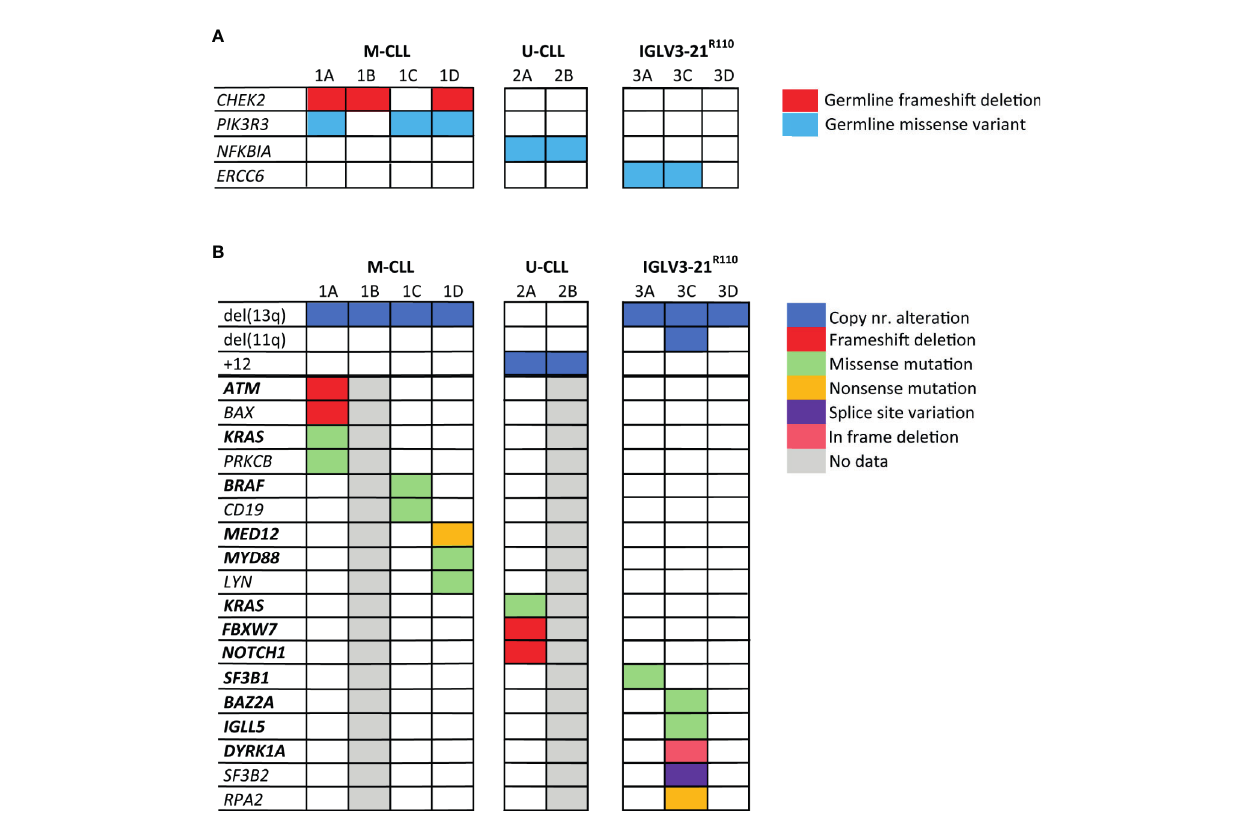
FIGURE 2 | Somatic mutations and germline variants detected by whole genome sequencing of the CLL families. In this fi gure, both germline variants (A) and somatic genetic alterations (B) detected in the CLL families are shown. The genes highlighted in bold text are genes, which have previously been identi fi ed as CLL driver genes. Genes that are not in bold text were identi fi ed during KEGG pathway analysis. Only mutations/variants with likely functional consequences related to CLL development are shown; mutations/variants that were previously reported to be benign or evaluated as benign by variant effect predictors were not